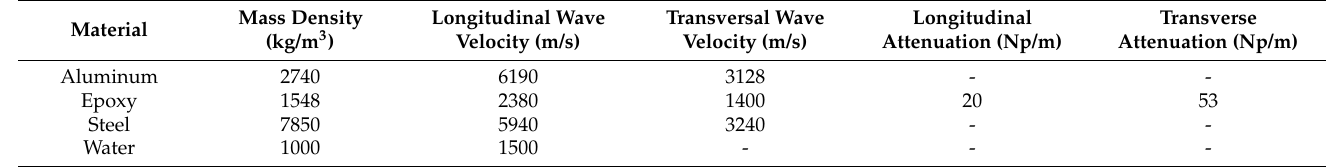
Table 1. Material properties of aluminum, epoxy, steel, and water (coupling fluid).